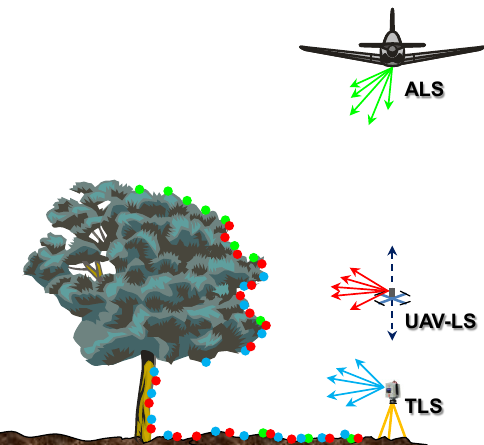
Figure 1. Illustration of the data acquisition with ALS, TLS and UAV-LS systems: the example contains 3D points acquired via ALS (green dots), TLS (blue dots) and UAV-LS (red